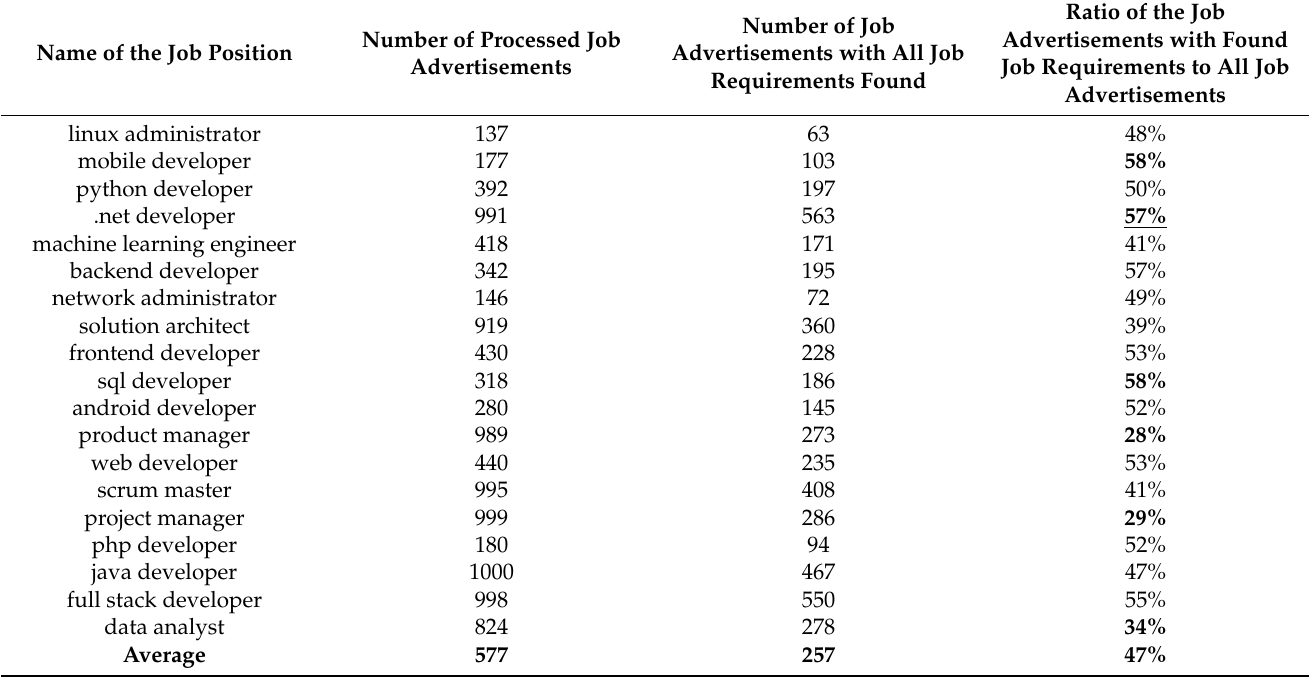
Table 4. Results of processing job advertisements using the machine learning with marking lists approach.